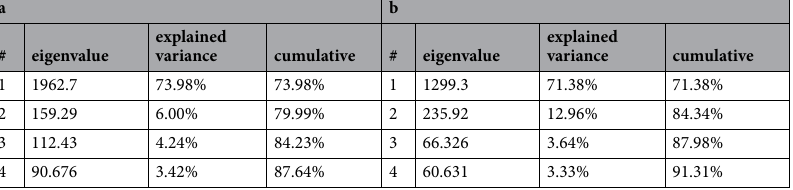
Table 1. Explained variances of the eigevalues for (a) the lower tropospheric temperature and (b) the Pacific SSTs presented in the respective regions of Fig.